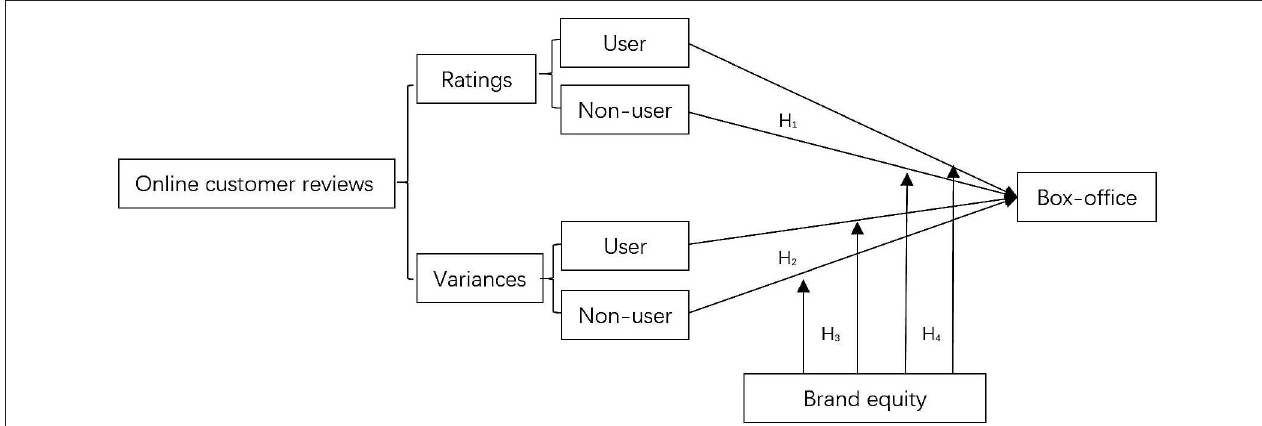
FIGURE 1 | Analytical model of the effects of verified users’ and unverified users’ online reviews on box-office